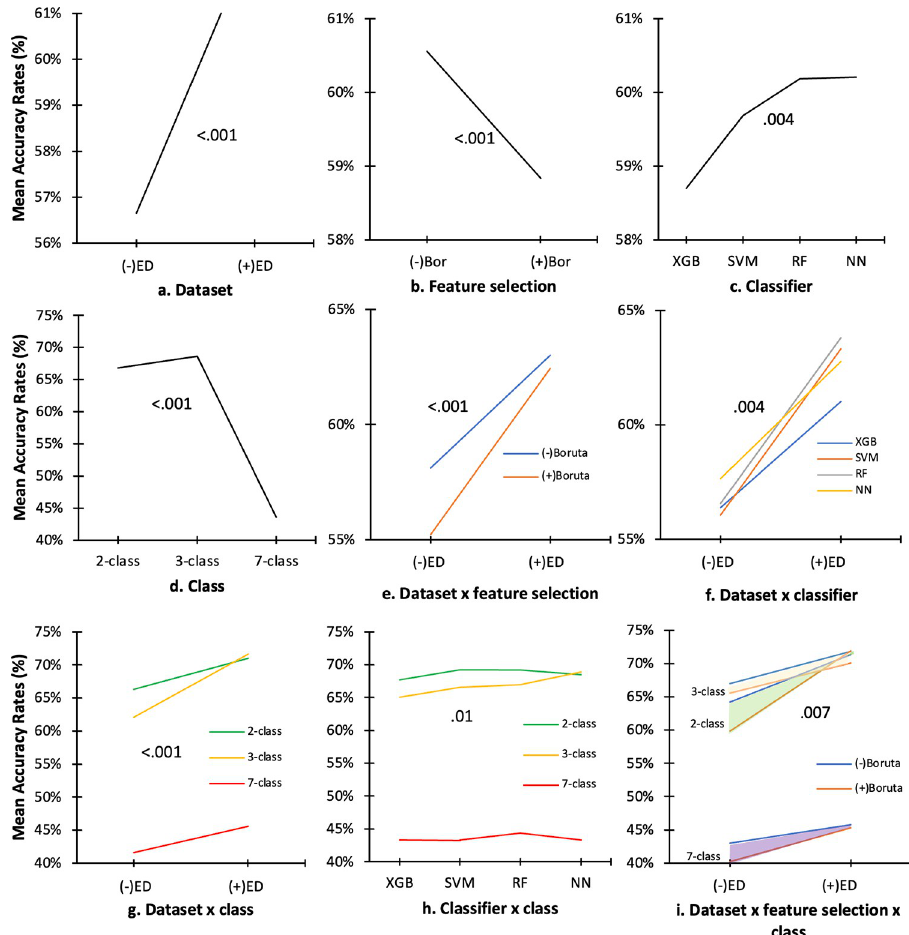
Fig 10. Three-way ANOVA results of the differences in the pooled mean classification accuracy rate (%) by dataset, feature selection, classifier, and class. (+) ED = dataset with environment data; (-) ED = dataset with environment data; (+) Bor = with Boruta feature selection; (-) Bor = without Boruta feature selection; XGB = eXtreme Gradient Boosting; SVM = support vector machine; RF = random forest; NN = neural network. pressure, hand movements, vocalizations, and timestamp-derived data, day, showing the high- est importance. In terms of classifiers, mean classification accuracy rates were not significantly different in all classes. Recalibrated dataset (inclusion of environment data), feature selection, classifiers, and classes had significant effects on the overall mean classification accuracy rates which indicate that higher mean classification accuracy rates were found in environment data, in non-Boruta trained dataset, in class 3, and SVM, RF, and NN classifiers. The significant interaction between datasets and feature selection, classifiers, and classes revealed that 1) non- Boruta training, 2) in all classifiers and, 3) in all classes, datasets with environment data had higher accuracy rates than dataset without environment data. The interaction between classi- fier and class also had significant effects on the mean classification accuracy rates where the use of NN in class 2, and SVM and RF in class 3 had the highest accuracy rates. Lastly, the interactions among recalibrated dataset, feature selection, and classes revealed that Boruta- trained dataset with environment data in class 2 and non-Boruta dataset with environment data in class 3 provided high mean classification accuracy rates.